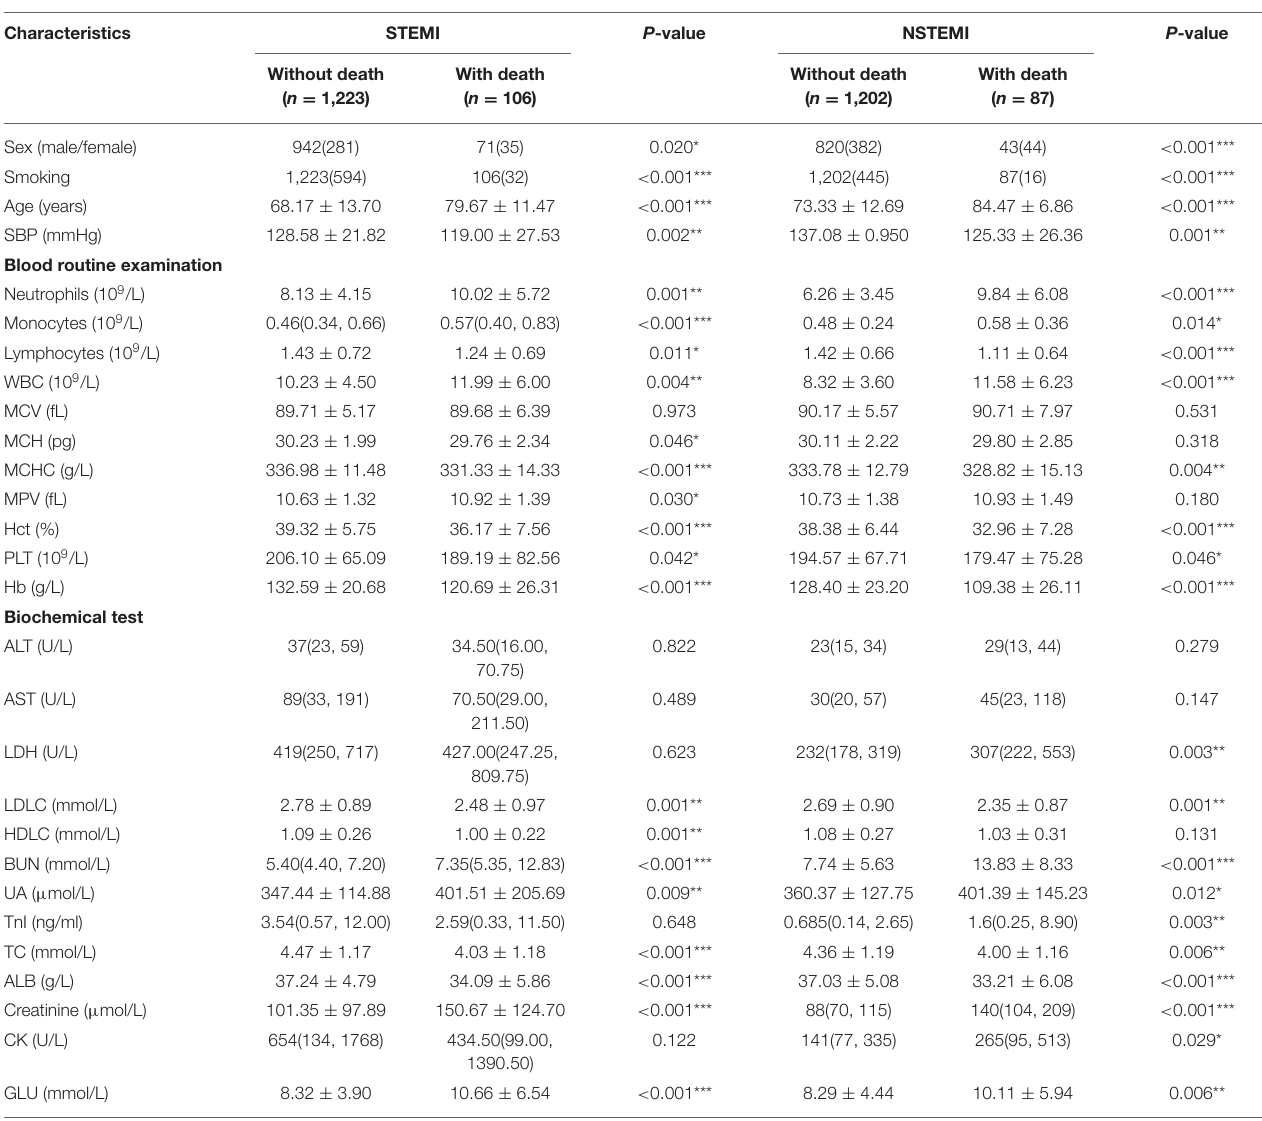
TABLE 1 | Basic characteristics of enrolling